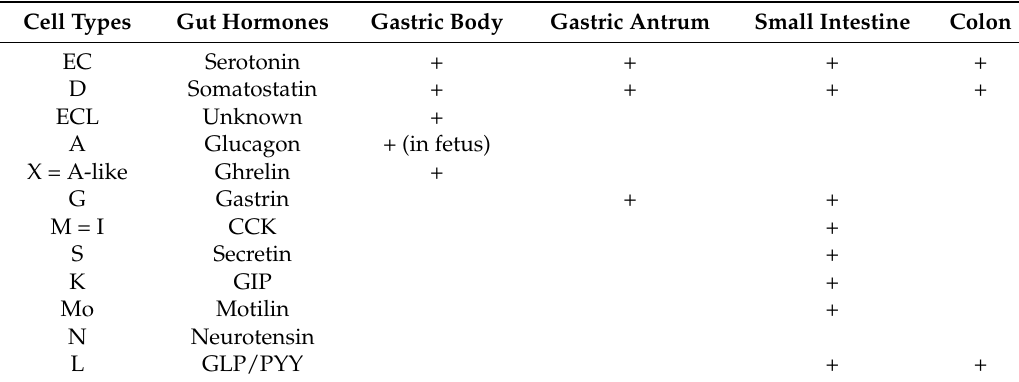
Table 1. Overview of enteroendocrine cells along the gastrointestinal